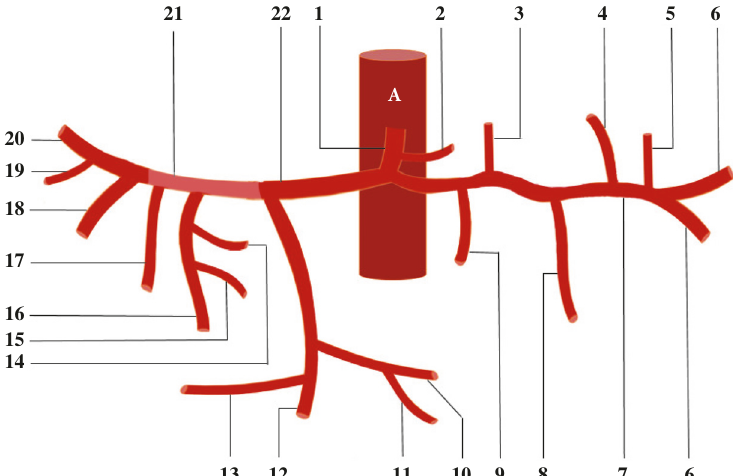
Figure 6: A: abdominal aorta; 1: celiac trunk, 2: left gastric artery, 3: accessory left gastric artery, 4: second left gastroepiploic artery, 5: second posterior gastric artery, 6: terminal branches of the splenic arteries, 7: splenic arteries, 8: left gastroepiploic artery, 9: posterior gastric artery,10: right gastroepiploic artery,11: superior anterior pancreaticoduodenal artery,12: gastroduodenal artery, 13: posterior superior pancreaticoduodenal artery, 14: right gastric artery, 15: superior duodenal artery, 16: left hepatic artery, 17: accessory left hepatic artery, 18: intermediate hepatic artery, 19: cystic artery, 20: right hepatic artery, 21: proper hepatic artery, and 22: common hepatic artery.